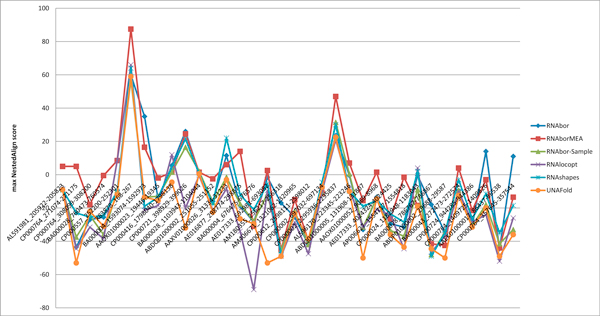
For each RNA sequence in the seed alignment from Rfam family RF00167 of purine riboswitch aptamers, we retrieved downstream flanking residues from the appropriate EMBL files, in order to ensure likelihood that the expression platform was included. Then the following six programs were run: RNAbor, RNAborMEA, RNAbor-Sample, RNAlocopt, RNAshapes, UNAFold. Each program outputs a number of near-optimal secondary structures, each according to different criteria. Taking RNAbor and RNAborMEA as examples, the programs RNAbor and RNAborMEA were run, in order to compute the MFE(k) structure and the MEA(k) structure, which have minimum free energy resp. maximum expected accuracy among all k-neighbors of the intial minimum free energy structures S0. Subsequently, we applied the program NestedAlign described in [36] to compute the structural similarity between the experimentally determined GENE ON structure for XPT guanine riboswitch of B. subtilis; i.e. the left panel of Figure 3. (Similar structures have positive scores; dissimilar structures have negative scores.) For each RNA in the seed alignment of RF00167, we determined the value k1, such the MEA(k1) structure for that RNA has the greatest structural similarity with the XPT GENE ON structure, as determined by NestedAlign. (See the left panel of Figure 3 for the experimentally determined GENE ON structure of XPT.) As earlier explained, we performed similar computations for the programs RNAshapes[39] and UNAFold [41], the programs RNAborMEA and RNAbor-Sample, described in this paper, and programs RNAbor[9] and RNAlocopt[34], developed by our lab. In 21 out of 34 instances, RNAborMEA produced the secondary structure most structurally similar to the experimentally determined XPT GENE OFF structure, as measured by NestedAlign.